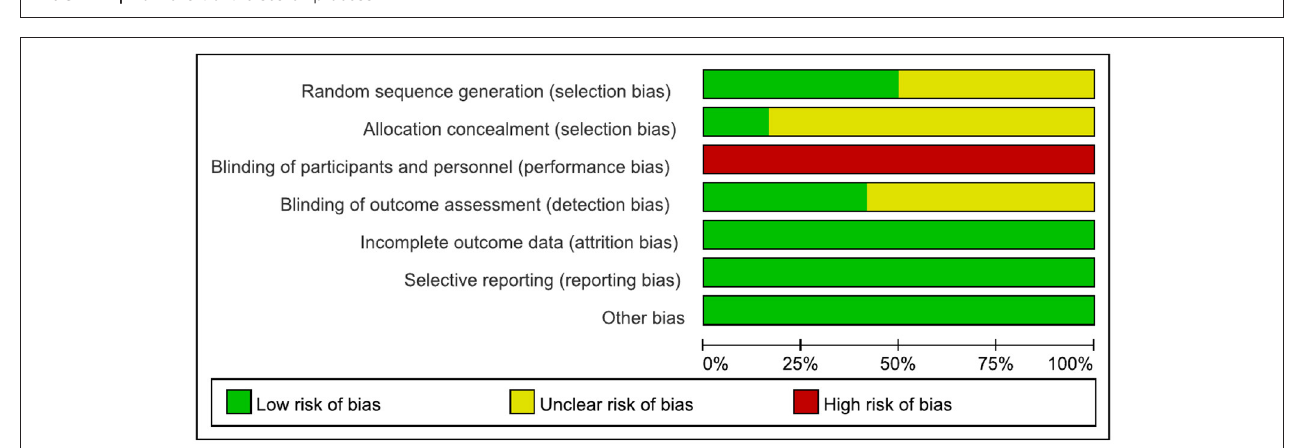
FIGURE 1 | Flow chart of the search process.